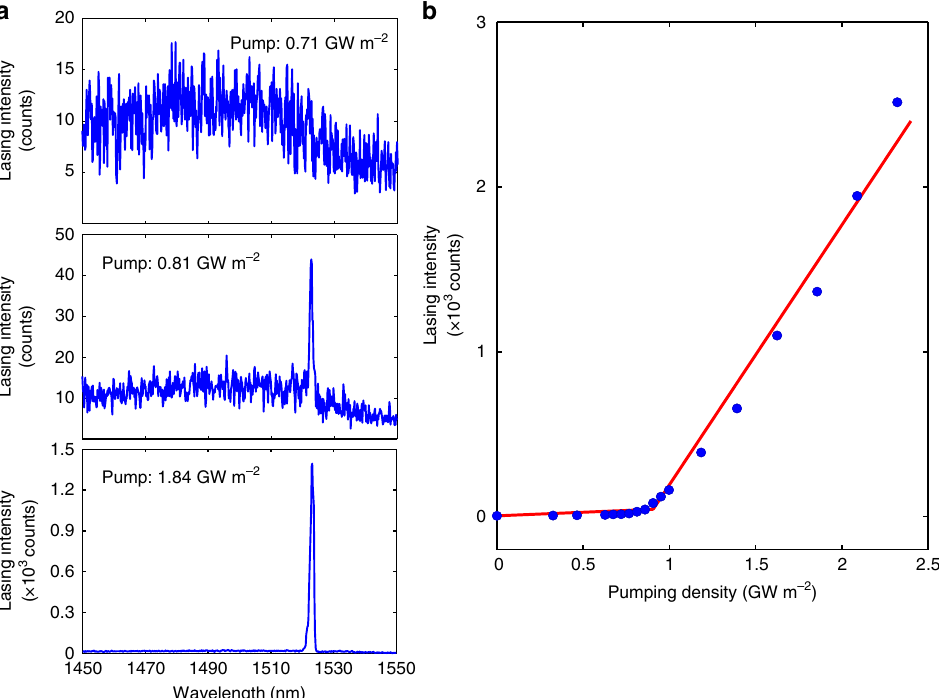
Fig. 2 Topological laser action. a Lasing spectrum of the structure of the topological hybrid silicon microlaser as a function of the pumping power much below the threshold (top panel), approaching the threshold (middle panel) and well above the threshold (bottom panel). As expected, as the pump power is increased, the output emission experiences a transition from broadband photoluminescence to a single narrow band lasing with an increased extinction ratio. b Pump dependence of the laser emission intensity, demonstrating the fi ngerprint of single-mode lasing: only one threshold with no other kinks in the light – light curve. Blue dots are experimental data and the red lines are linear fi ts with least squares of the data before and after the lasing threshold,